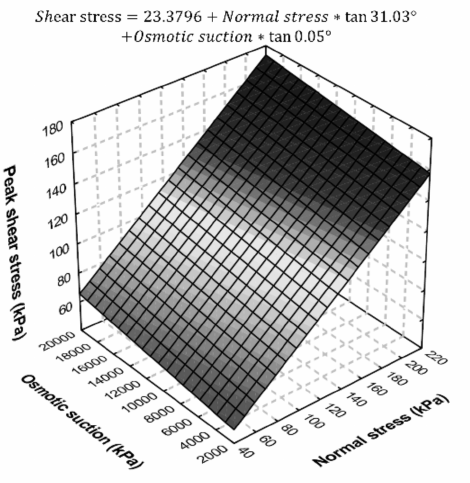
Figure 5. Contaminated soil shear strength model based on osmotic suction and normal